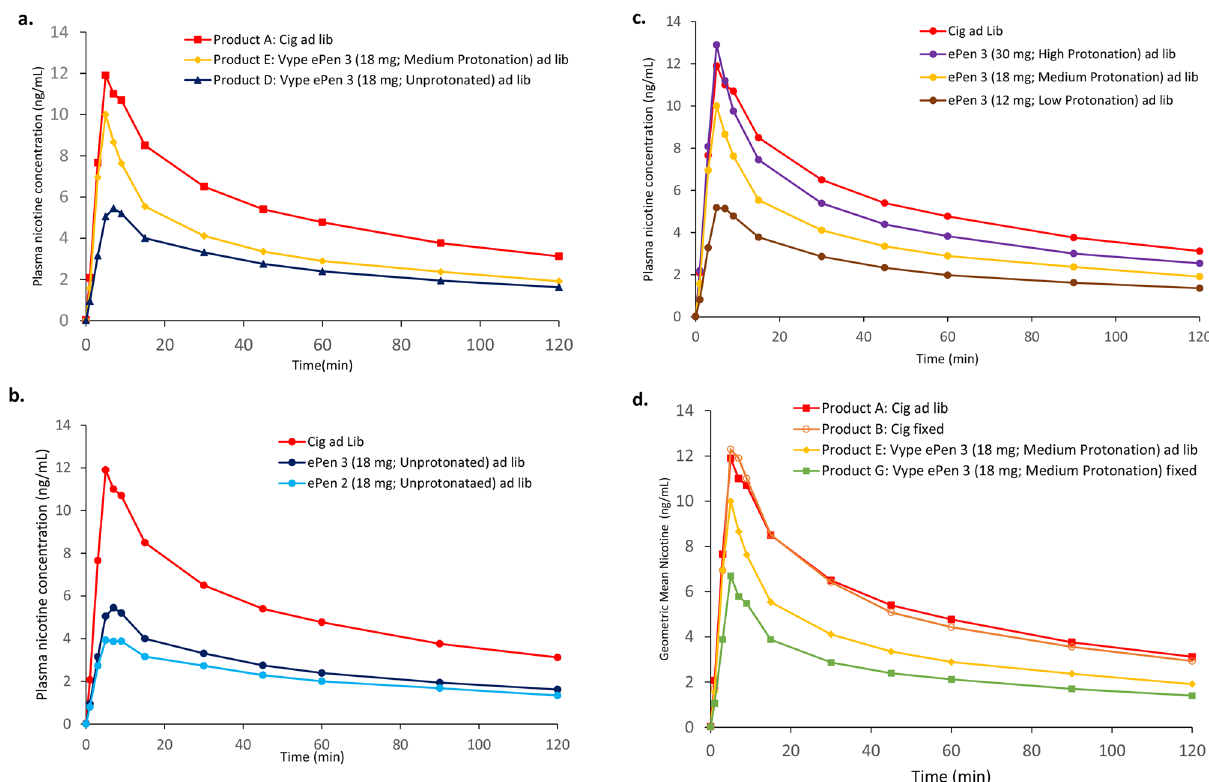
Figure 1. Pharmacokinetic profiles: mean plasma nicotine concentration of study products on a linear scale over 120 min ( a ) effect of nicotine salt ( b ) effect of device ( c ) effect of nicotine and protonation (acid) levels ( d ) effect of puffing